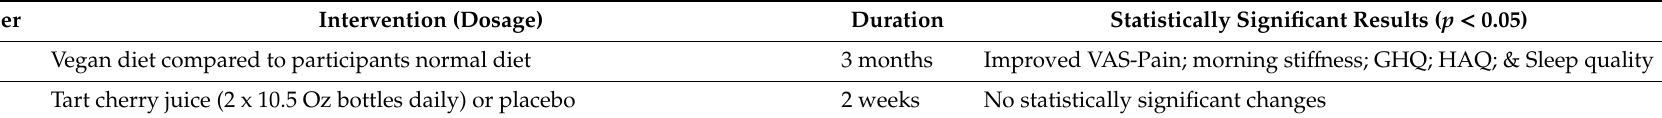
Table 3. Study Intervention and statistically significant